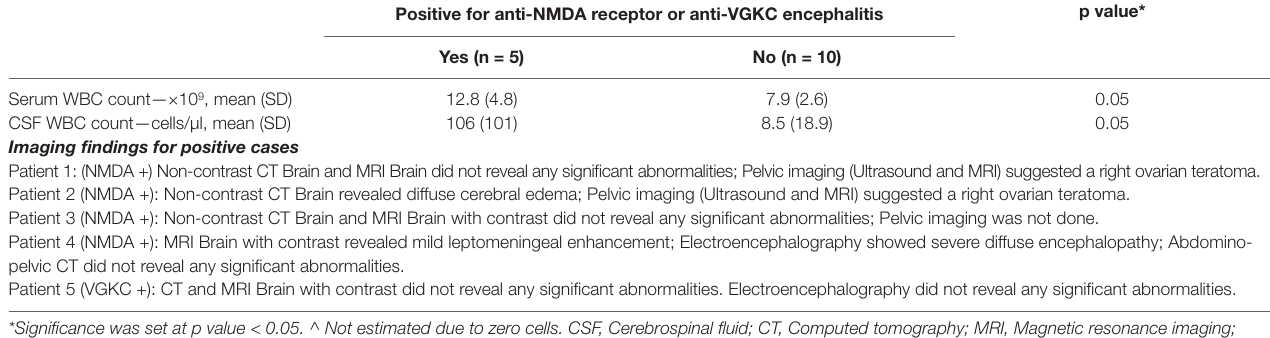
tABLE 3 | Baseline laboratory and radiological